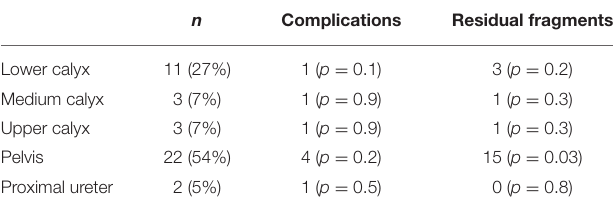
TABLE 3 | Complications and residual lithiasis in each